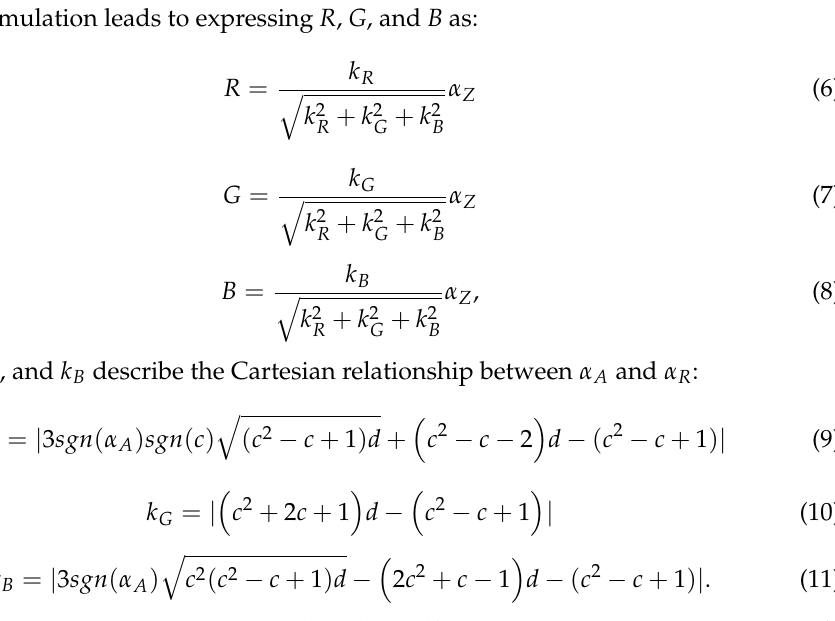
Figure 3. Correspondence between ARC components α A , α R , α Z , and the surface in the ARC and RGB space that each component